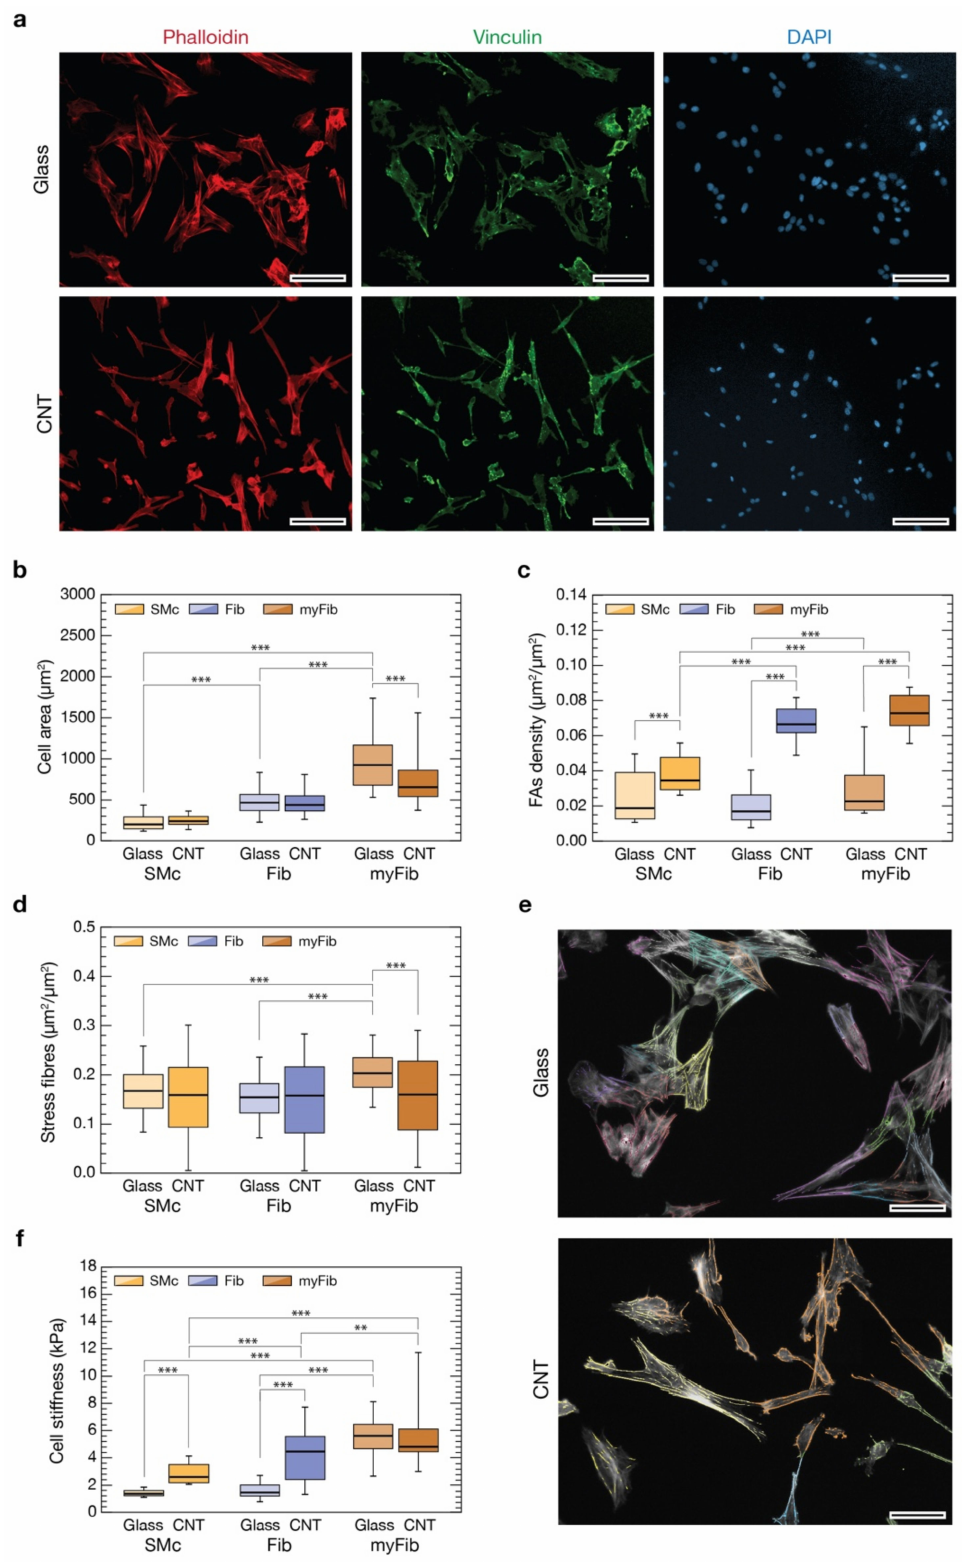
Figure 3. Evaluation of differences in cell parameters based on cell morphology. In ( a )